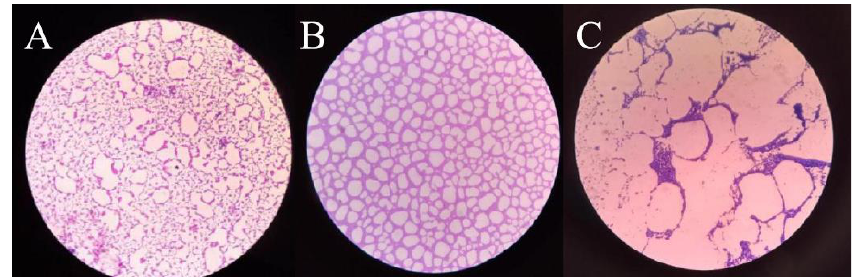
Figure 6. Crystal violet stained biofilm. ( A – C ) represented the biofilms cultured for 12 h, 24 h and 48 h respectively, observed by 40× magnification microscope.